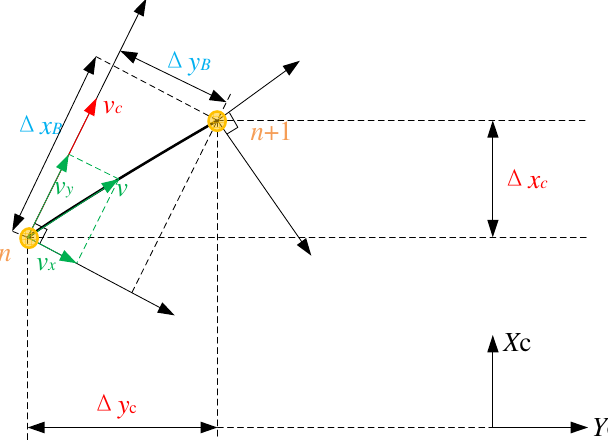
Figure 6. The velocity decomposition.